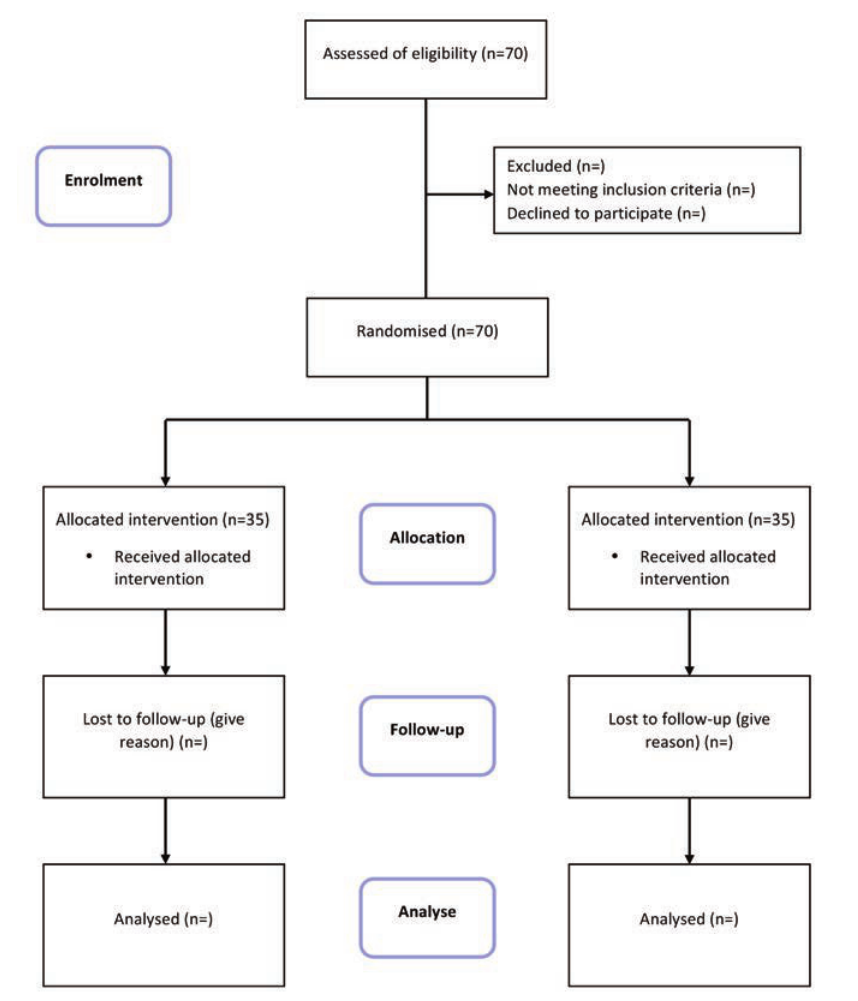
Flow chart of randomised control Fig. 1: